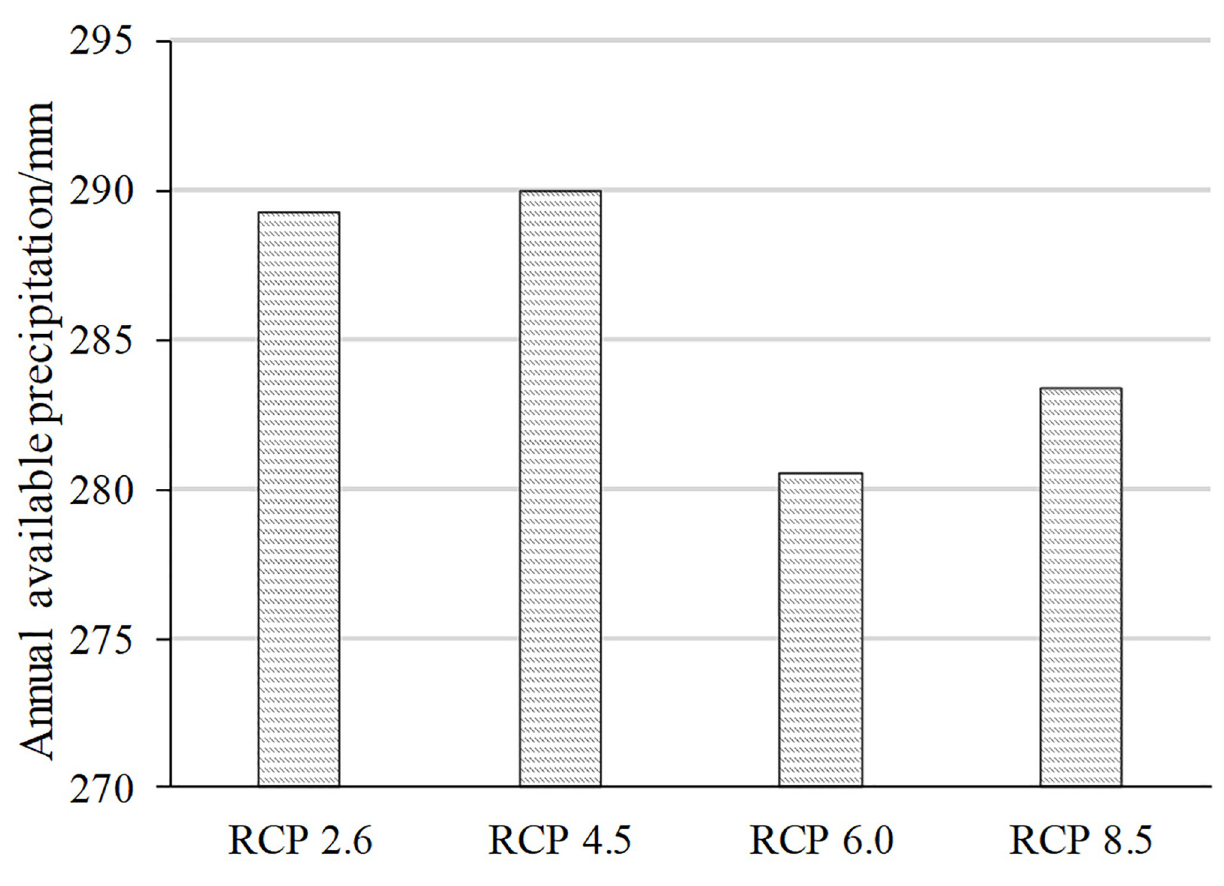
Fig 8. Average annual available precipitation in China under different